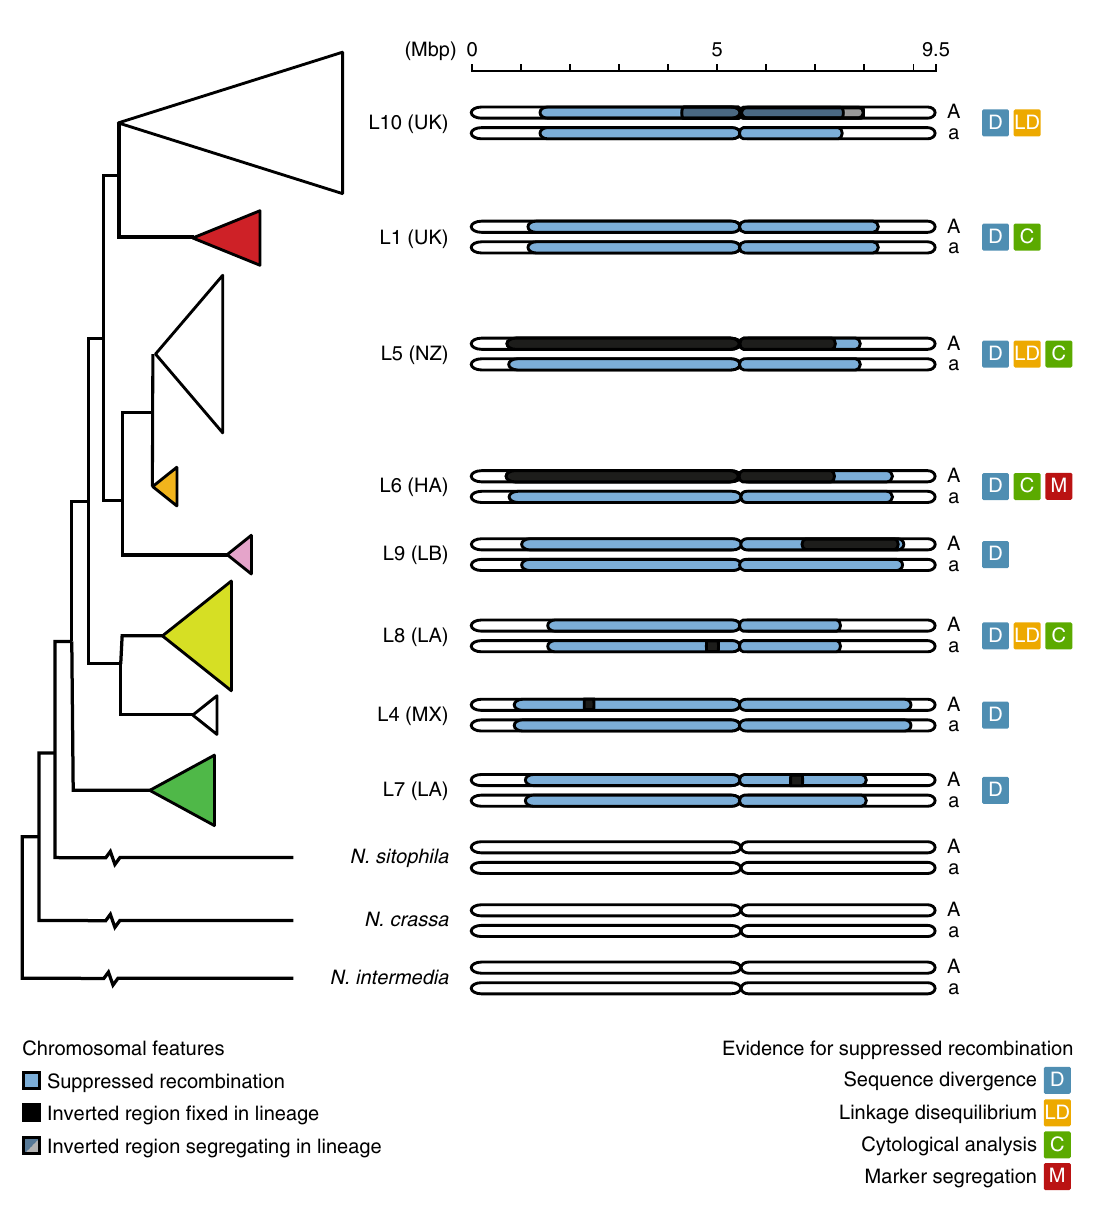
Fig. 2 Structure of the mat chromosome across N. tetrasperma lineages. All inversions above 100 kbp on mat chromosomes identi fi ed in this study, plotted per lineage. The phylogenetic tree is adapted from Corcoran et al. 27 and the colours of the fi lled triangles correspond to the colours used in Fig. 1. Several studies have provided different types of evidence for suppression of recombination along the mat chromosome in N. tetrasperma . Gallegos et al. 26 investigated strains from Lineages 1, 5, 6 and 8 and determined both that they lack chromosomal synapsis at pachytene in most of the mat chromosome, and that no crossovers occurred between a set of genetic markers for a Lineage 6 heterokaryon. Corcoran et al. 27 identi fi ed a region of elevated sequence divergence between the mating types within a heterokaryon for all N. tetrasperma lineages included in this study, as well as a region of elevated linkage disequlibirium for three of them. The combination of evidence indicates that all N. tetrasperma lineages carry a region of suppressed recombination on the mat chromosome (blue bars), but the size of this region differs between lineages 27 . Black bars show inverted regions that are fi xed on a mating type within a lineage. All identi fi ed inverted regions are fi xed in all investigated strains of the same mating type within its lineage, except a 3.6 Mbp inversion only identi fi ed in CJ01 mat A in Lineage 10. The inverted region in Lineages 5 and 6 is the only one that is shared between lineages. Neurospora sitophila , N. crassa and N. intermedia share the gene order with the majority of N. tetrasperma strains, but the mat chromosome recombines freely. This distribution of inversions shows that all identi fi ed inversions are derived and that only the suppression of recombination is shared between all analyzed strains of N.